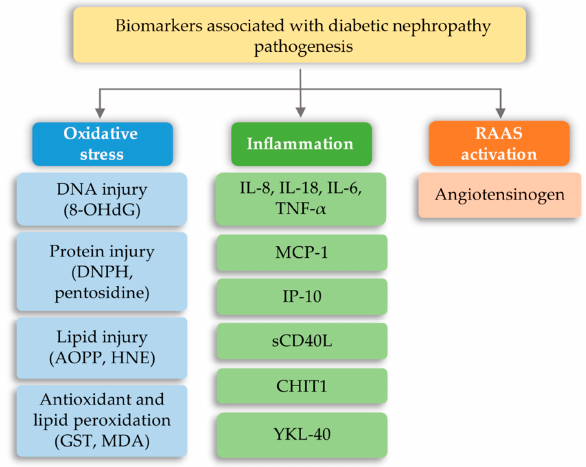
Figure Figure 8. Biomarkers associated with diabetic nephropathy pathogenesis (based on [157]). 8-OHdG— 8-hydroxy-2’-deoxyguanine; AOPP—advanced oxidation protein product; CHIT1—chitotriosidase; DNPH—2,4-dinitrophenylhydrazine; GS—Glutathione s-transferase; HNE—4-hydroxy-nonenal; IL- 6—interleukin 6; IL-8—interleukin 8; IL-18—interleukin 18; IP-10—interferon-inducible protein-10; MCP-1—Monocyte chemoattractant protein-1; MDA—malondialdehyde; sCD40L—soluble CD40 ligand; TNF- α —Tumor necrosis factor alpha; YKL-40—cartilage glycoprotein 40.